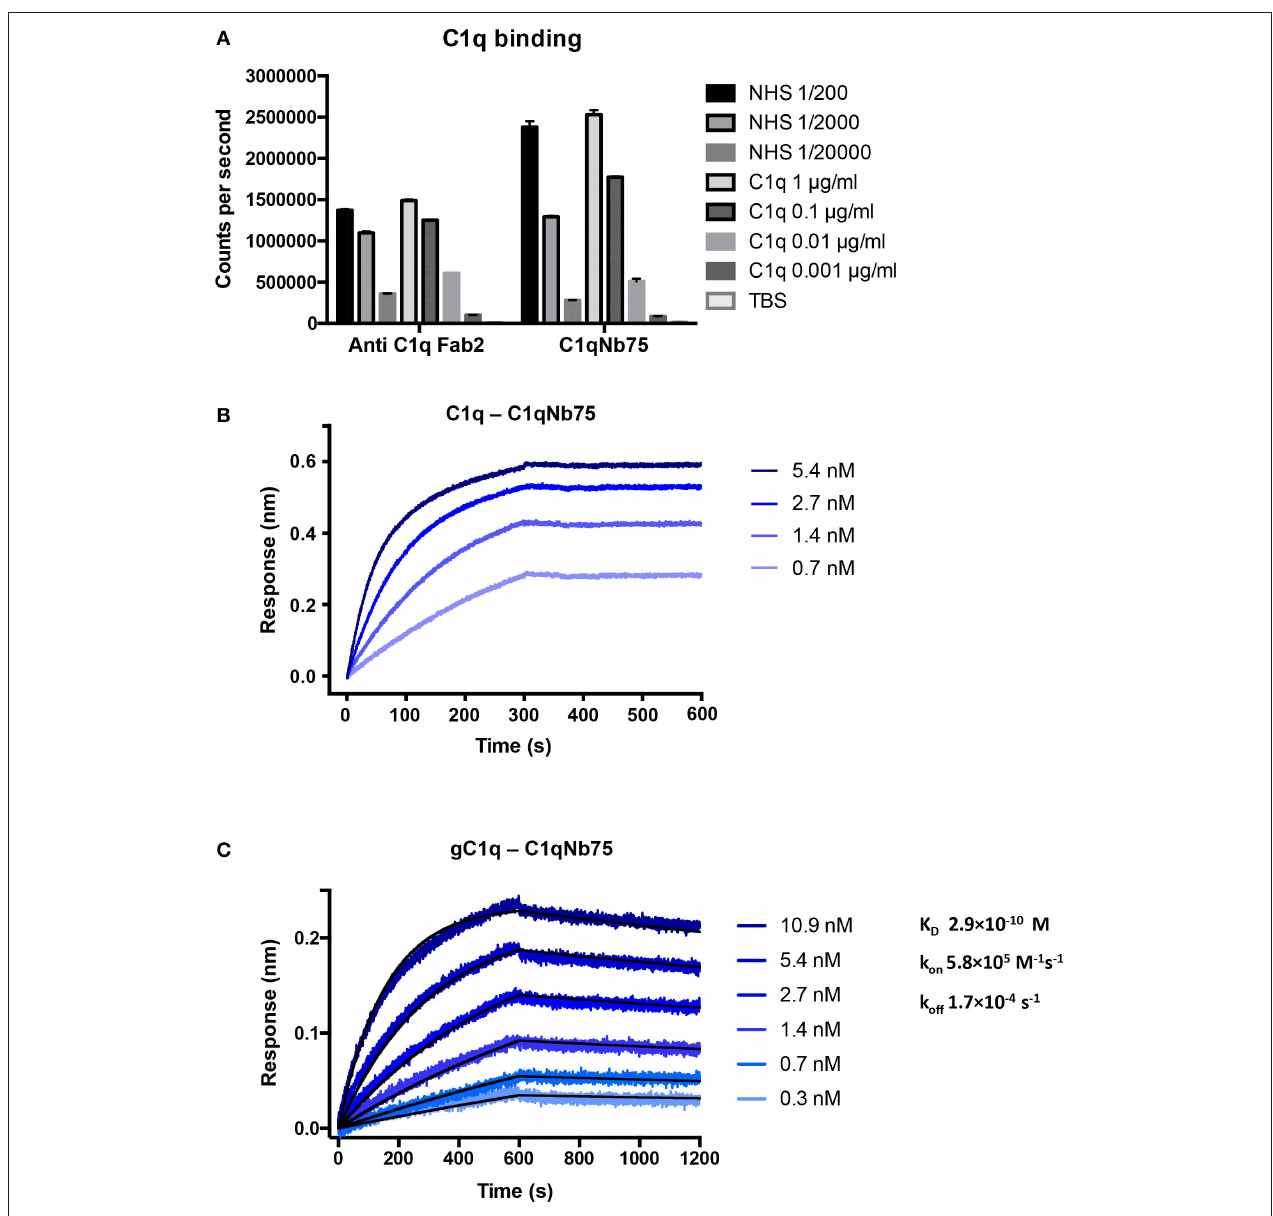
FIGURE 1 | C1qNb75 binds with high affinity to human C1q. (A) Solid-phase immunoassay (TRIFMA) with anti-C1q Fab2 or C1qNb75 coated in microtiter wells. The binding of purified C1q or C1q in NHS is measured. The signal is given as counts per second after measurement by time-resolved fluorometry. Shown are mean and SD. (B) Bio-layer interferometry (BLI) measurement of the interaction between purified C1q in solution and immobilized C1qNb75. (C) As in previous panel but showing the interaction between recombinant gC1q and immobilized C1qNb75 with calculated k on , k off , and K D . The Experimental data (blue curves) was globally fitted to a 1:1 binding model (black